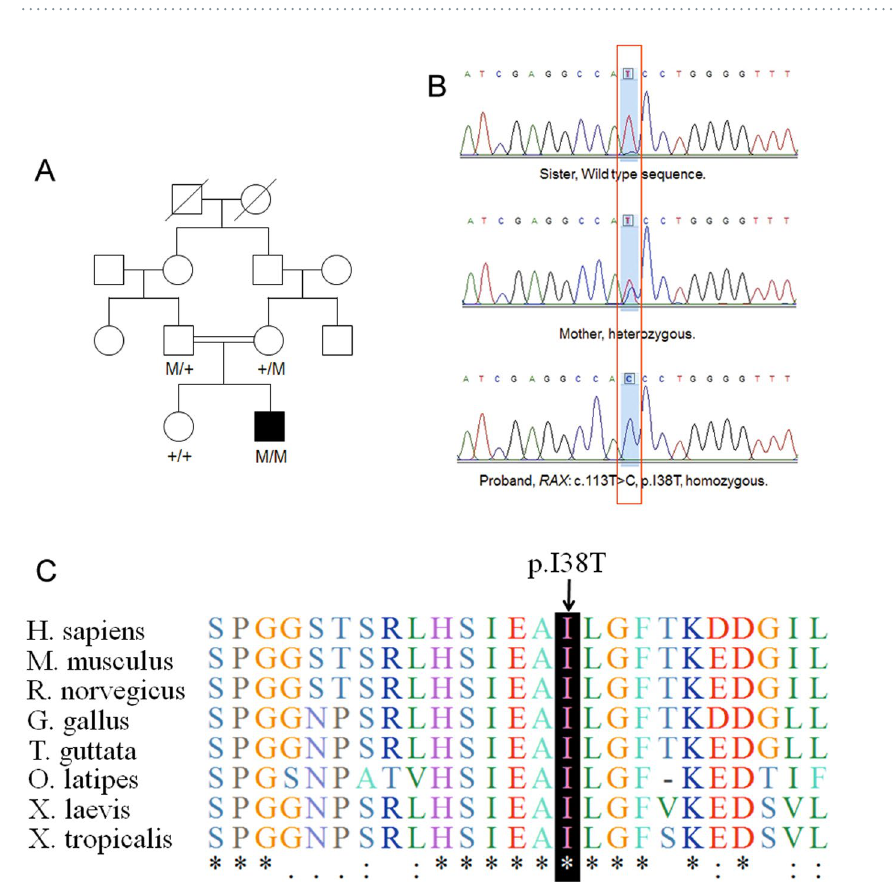
Figure 3. Identification of RAX Mutation in the family with ocular coloboma. ( A ) Pedigree. ( B ) Sanger sequencing confirmed the segregation of the homozygous missense mutation, c.113 T > C (p.I38T). ( C ) Evolutionary conservation of amino acid residues Ile38 in RAX. Alignments of the area of novel mutation, in various species, which showed the Isoleucine acid at position 38 is highly conserved. Sequencing alignments performed with Clustal